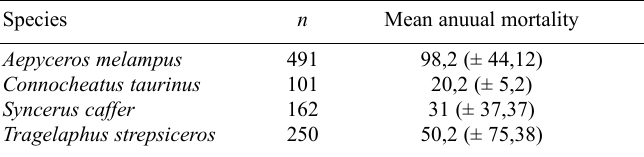
Annual variation in the natural mortalities of four ungulate species on Letaba Ranch, Limpopo